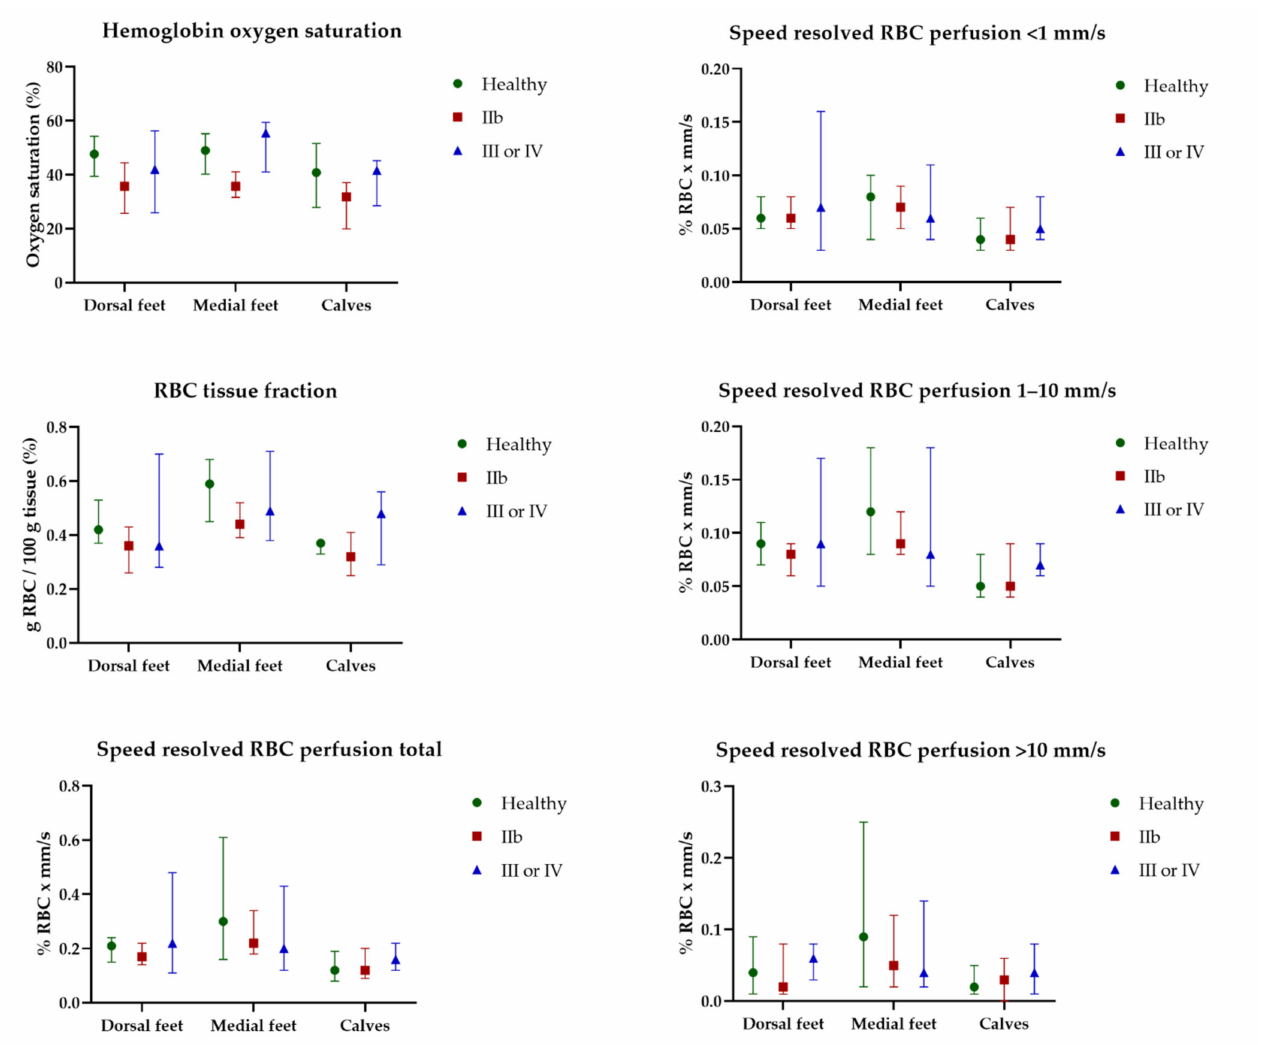
Figure 5. Continuous enhanced perfusion and oxygen saturation (EPOS) variables at 32 ◦ C between healthy volunteers, patients with Fontaine class IIb, and patients with Fontaine class III or IV measured on the dorsal side of the foot, medial side of the foot, and the lateral side of the calf. Data are presented as median (interquartile range). Healthy: healthy volunteer, RBC: red blood cell, IIb: patients with Fontaine class IIb, IV: patients with Fontaine class III or